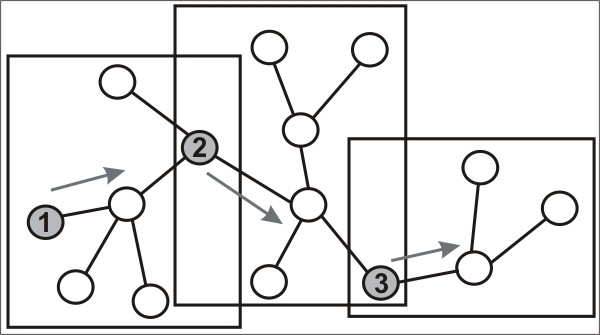
Frame-by-frame network navigation. A search begins at node 1 in the left-most window. Once node 2 is reached in the middle window, a new search is performed to center the network around that node. This process is repeated at node 3 in the right-most window. A connected network can be fully traversed using this method. This localized navigation approach works well to reconcile the exponential complexity of networks and the limitations of two-dimensional viewers.